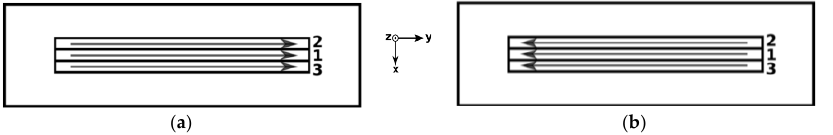
Figure 1. Laser scan sequences during the deposition for ( a ) odd-numbered layers and ( b ) even- numbered layers. The arrows show the scanning direction, and the numbers, 1 – 3, show in which order the passes are done.